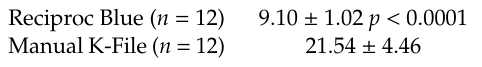
Table 2. Working time (min, expressed as mean ± SD).